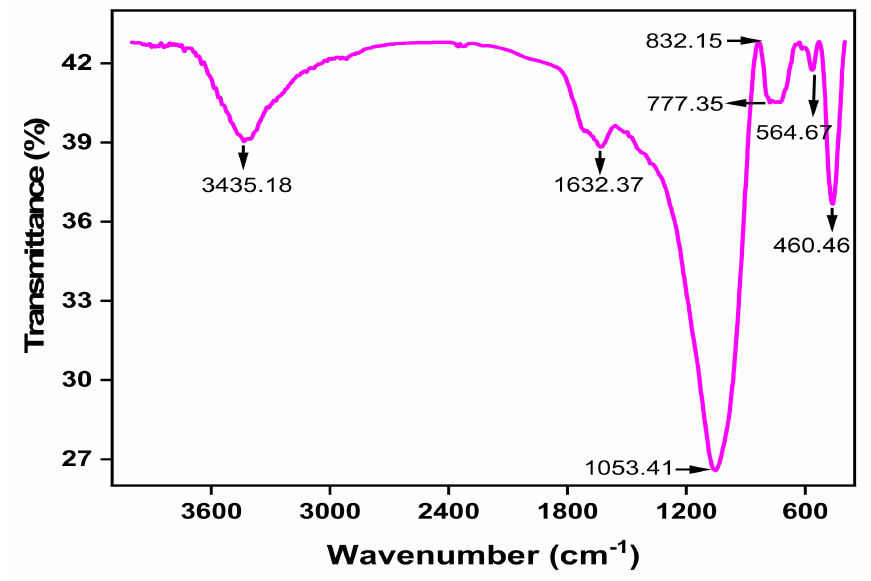
Figure 3. FTIR spectra of HWSB after exposure to elevated